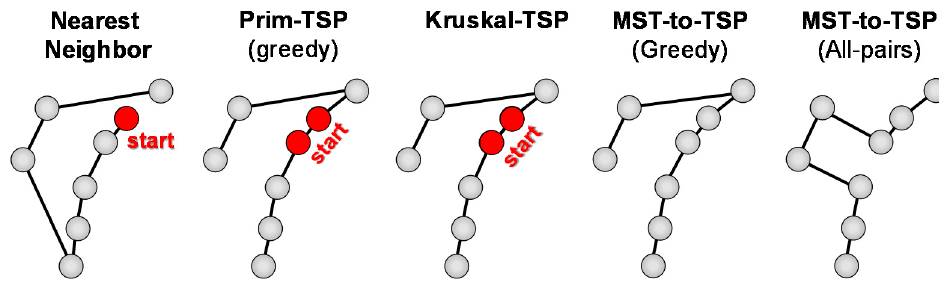
Figure 13. Parallel chains where only MST-to-TSP (All-pairs variant) finds the optimal path.